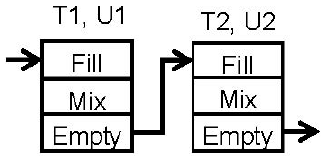
Figure 3. A simple recipe network.